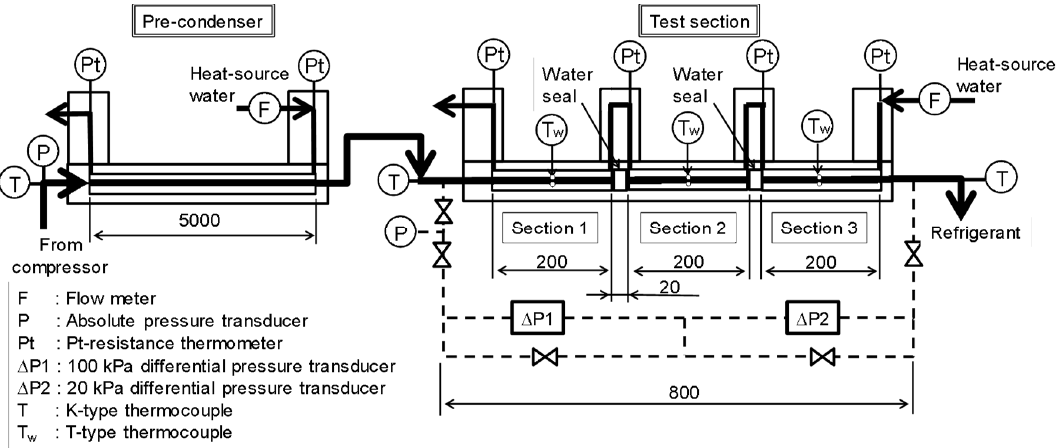
Figure 2. Details of the pre-condenser and test section. Table 1. Measurement accuracies of the measuring devices. Instrument